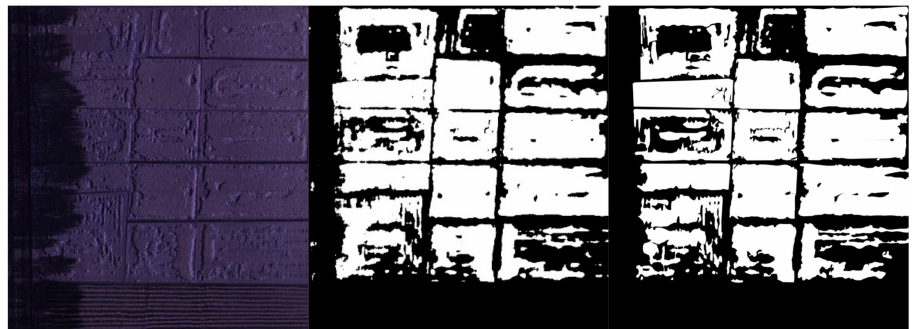
Figure 9. Multispectral original image ( left ), segmentation result image ( middle ) and manually processed ground image ( right ).